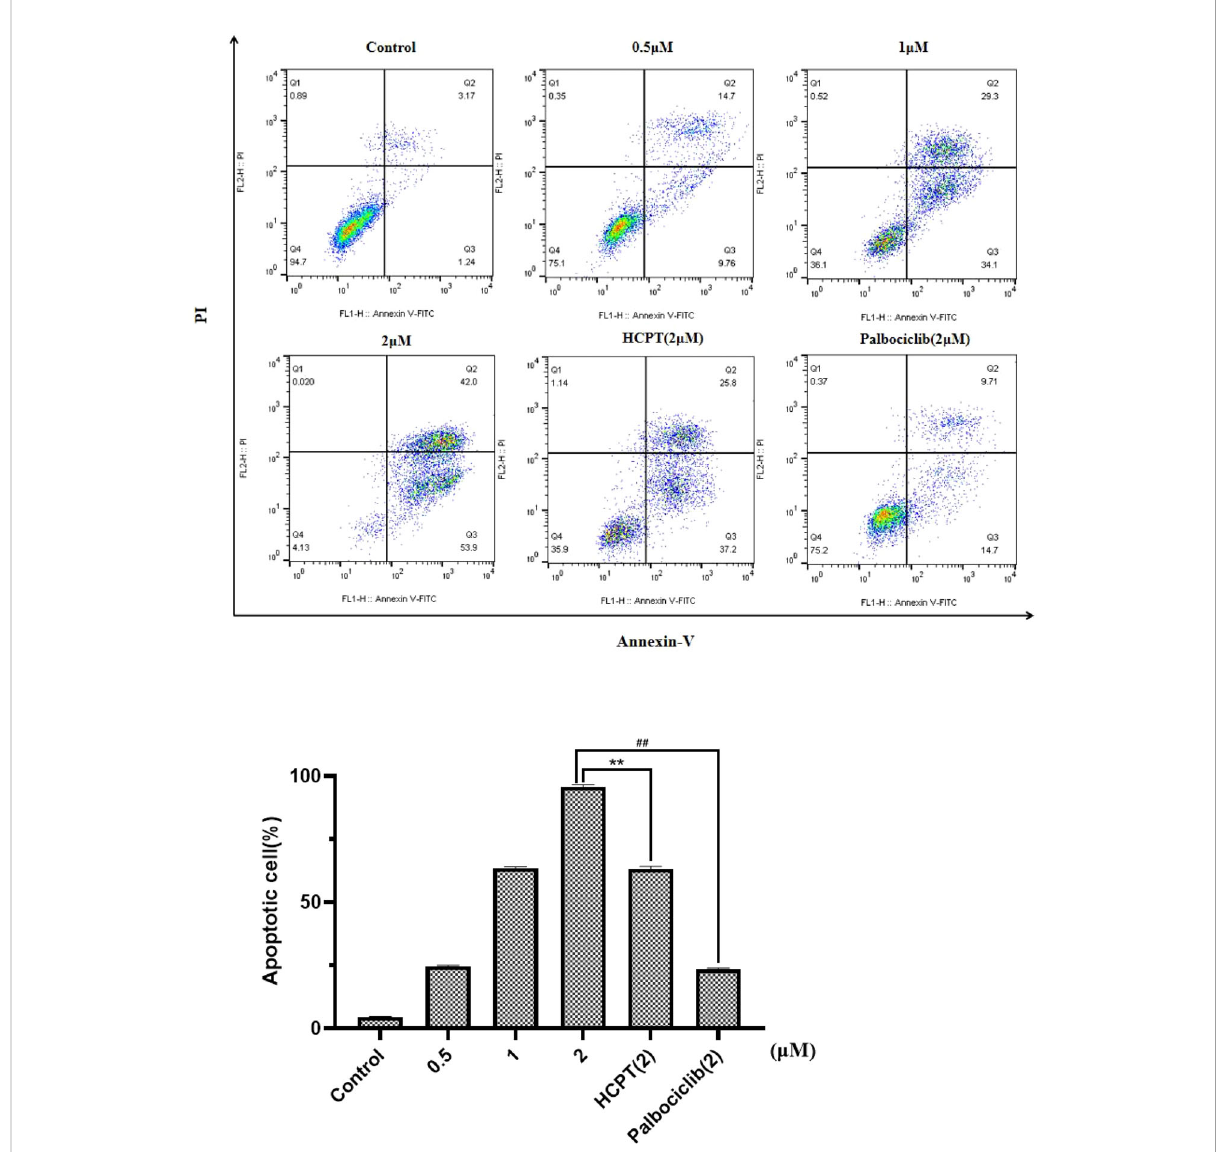
FIGURE 5 Effect of HP-1 on the apoptosis of NCI-H460 cells in concentration dependence. Data shown are the mean ± SD of three independent experiments (** p <0.01, compared to HCPT; ## p <0.01, compared to